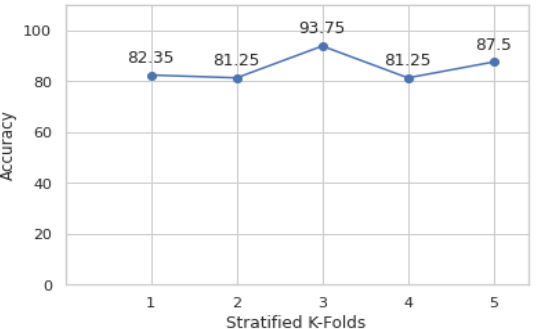
Figure 6. The classification accuracies of the RF model using the stratified five-fold cross-valida-